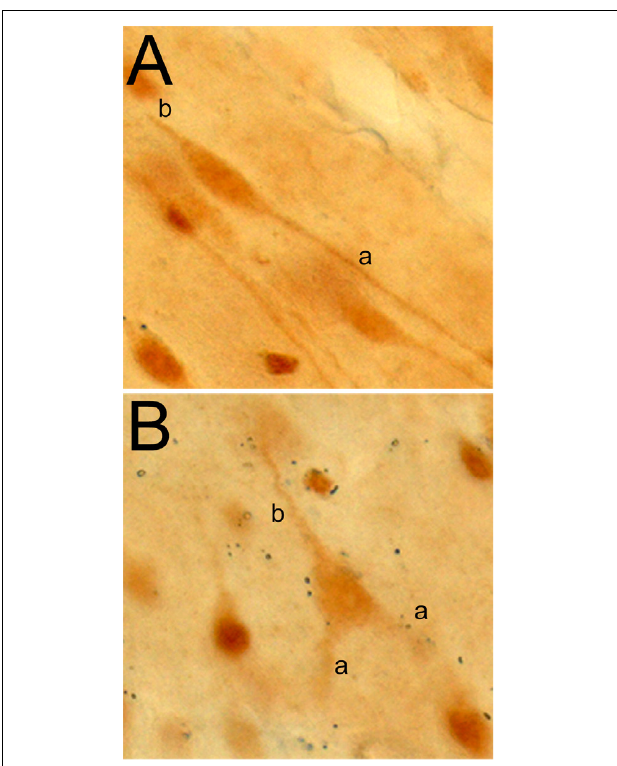
FIGURE 8 | Photomicrographs of a VEN (A) and fork neuron (B) in the macaque monkey insula, immunostained with an antibody raised against the vesicular monoaminergic transporter 2 (VMAT-2; 1:1000, AB1598P, Millipore). The letters “a” and “b” in each panel refer to the apical and basal dendrites, respectively. Adapted with permission from Evrard